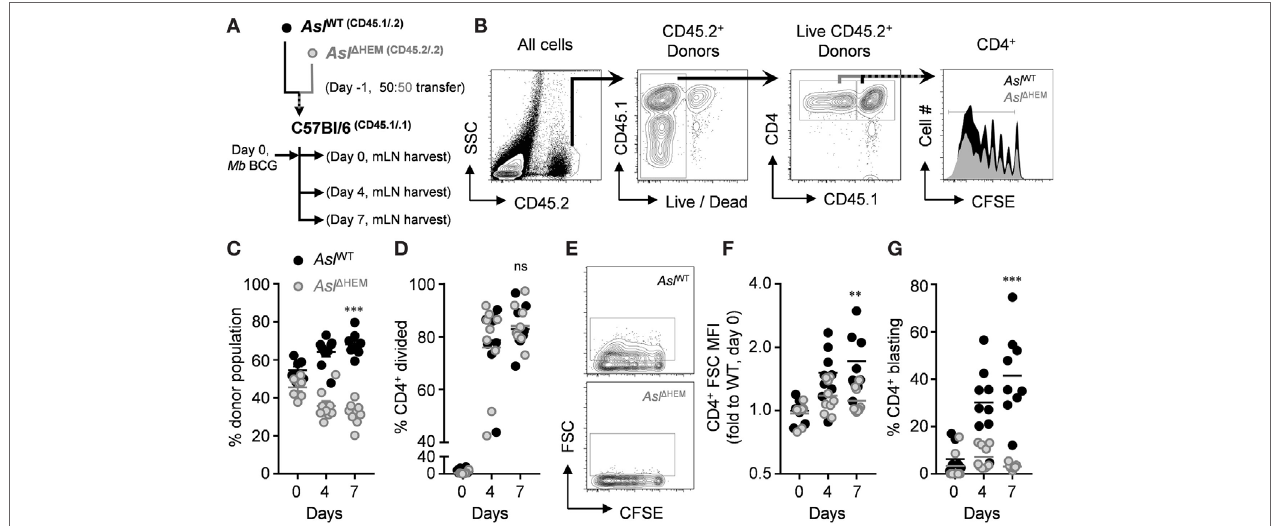
FigUre 5 | l - c itrulline metabolism drives anti-mycobacterial CD4 + T cell blasting and accumulation in the mLN upon M. bovis BCG infection. (a) CD4 + T cells were collected from P25k; Asl flox/flox ;Tie2-cre ( Asl Δ HEM ) and P25k; Asl flox/flox ;( − ) ( Asl WT ) mice and labeled with carboxyfluorescein succinimidyl ester (CFSE). Cells were mixed at a 50:50 ratio and transferred i.v. to C57Bl/6 mice ( n ≥ 7) one day prior to M. bovis BCG infection (i.n., ~5 × 10 6 colony forming units). Lung draining mLNs were collected the day after transfer from uninfected mice (day 0), and at 4 and 7 days postinfection. (B) Each donor population and the recipient cells were identified based on congenic CD45 variants, and proliferation of donor T cells was measured by CFSE dilution. Cells were analyzed for ratio of total donor cells (c) , proliferation (D) , FSC-calculated size (e,F) , and blasting frequency [ (g) , see gated population in (e) ]. Data are combined from two experiments. ** p < 0.01, *** p < 0.001 by two-way